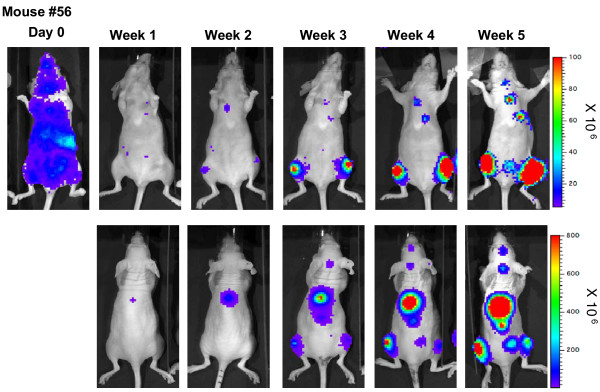
Multiple metastases detected in vivo following intracardiac injection of D3H2LN cells. Ventral (upper panels) and dorsal (lower panels) images taken over time from a representative nude mouse injected with D3H2LN cells are shown. Pseudocolor scale bars were consistent for all images of ventral or dorsal views in order to show relative changes at metastatic sites over time.